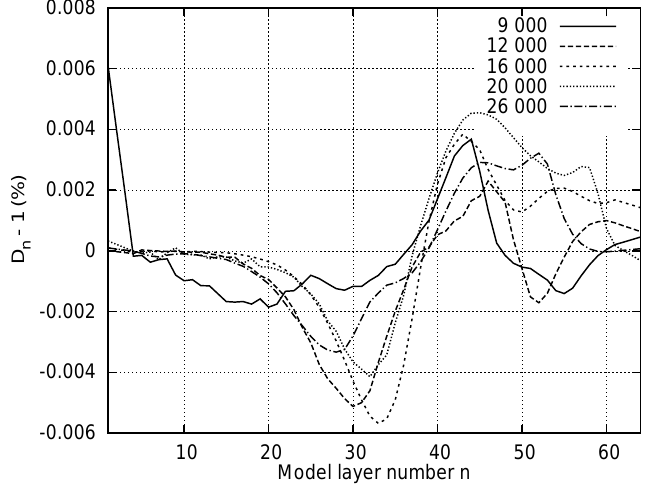
Fig. 5. The final high-precision local ratio of the absorbed and radiated radiative flux (in %). The result is obtained computing the Jacobian by the Levenberg-Marquardt method and thereafter improving it by iterations of the Broyden loop. In the models log g = 4 and in the legend – the effective